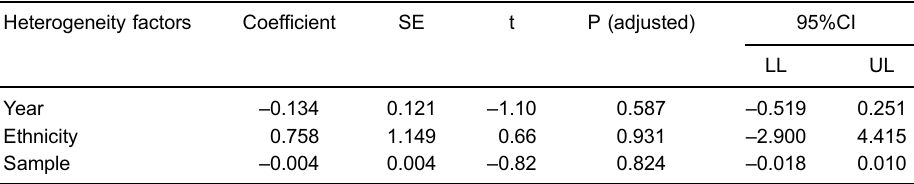
Table 2. Multi-factor regression analyses of Lauren grade of gastric cancer (GC) patients based on the 9 included studies. Heterogeneity